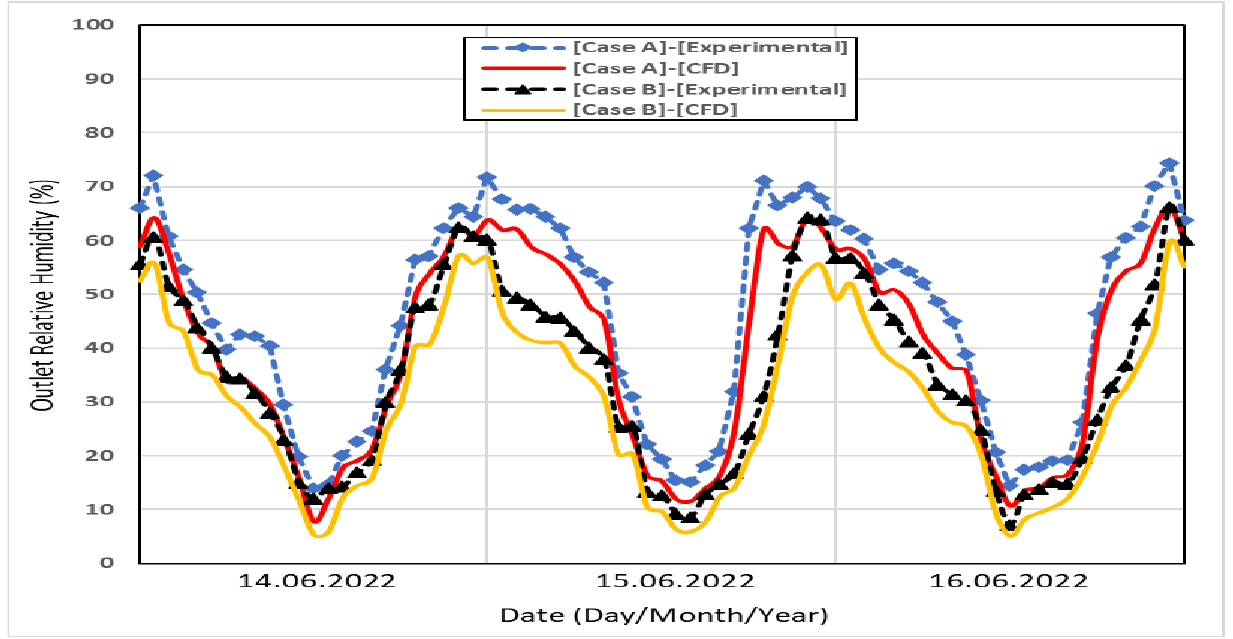
Figure 13. Validation of the CFD outlet airflow relative humidity variation and the experiment data for the two tested